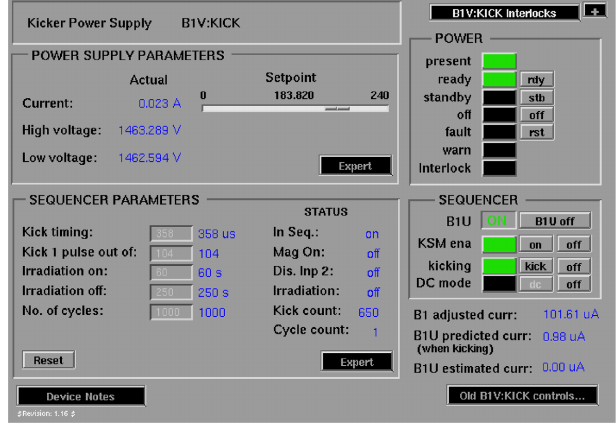
FIG. 18. EPICS control screen for kicker magnet showing controls for the power supply (top right), controls for the sequencer module (bottom right), flat-top magnet current (top left), and timing parameters (bottom left).